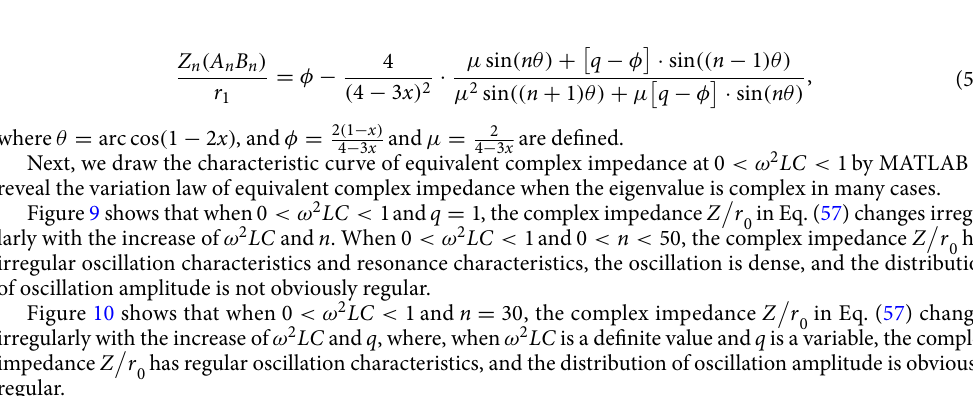
r 0 with respect to n and (cid:31)